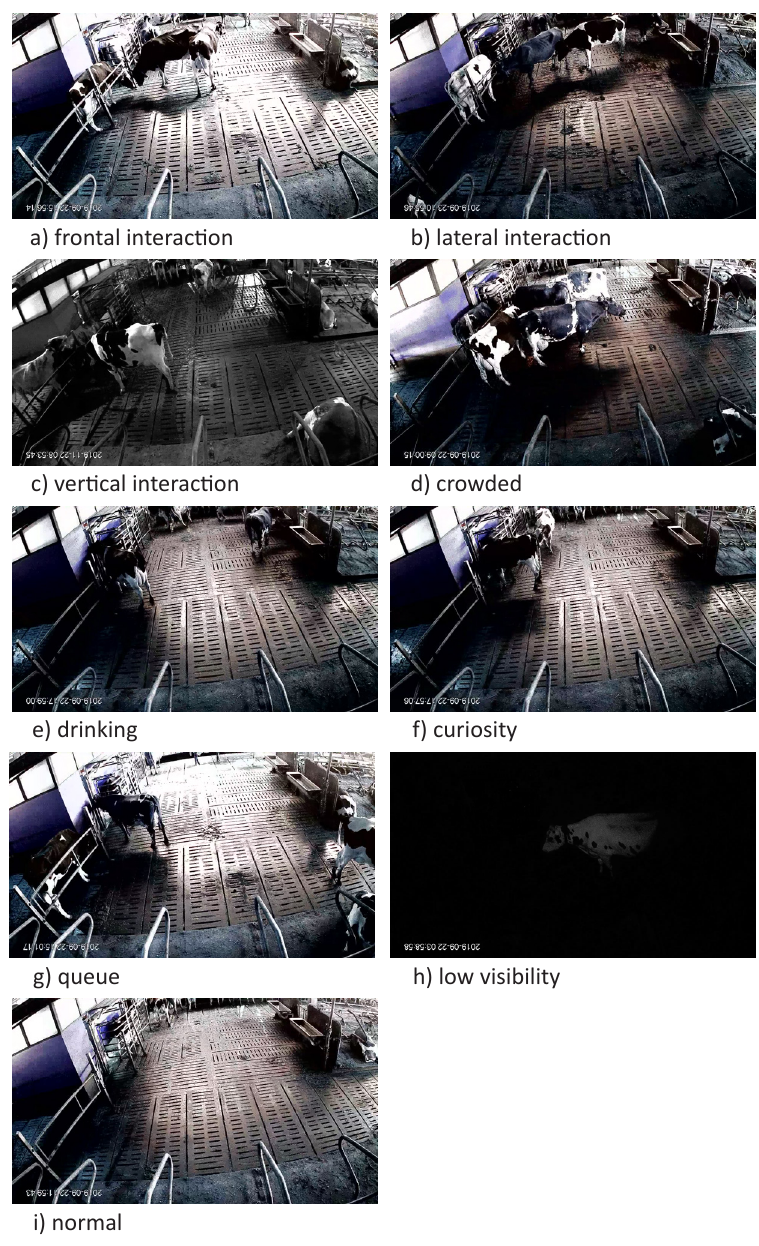
Fig. 5. Sample image of each class